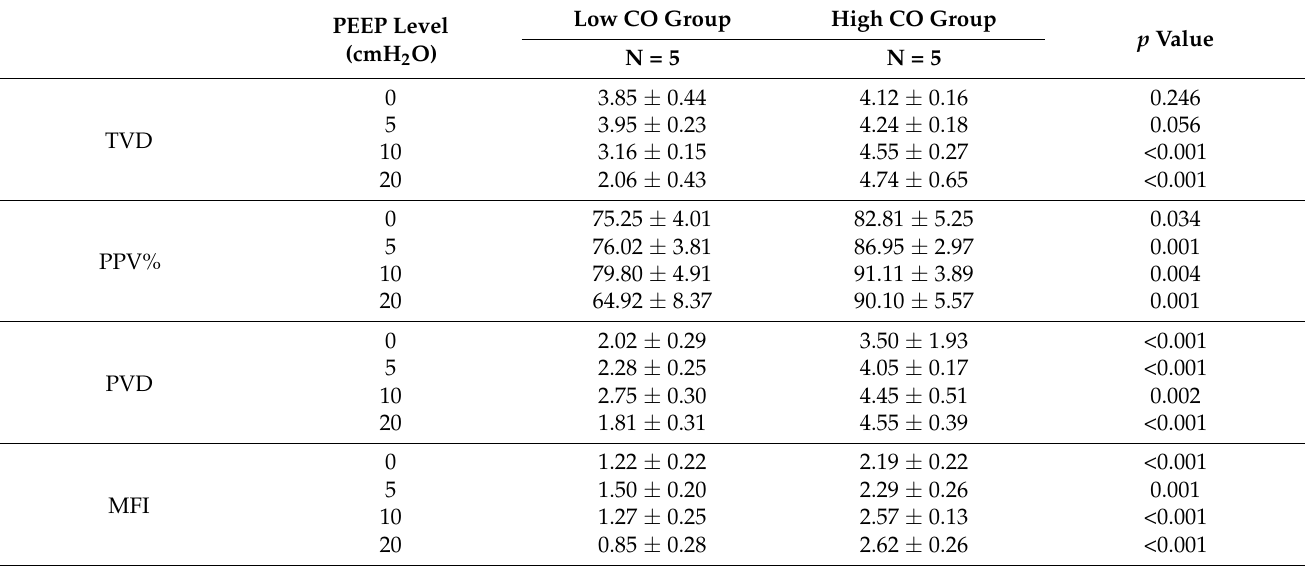
Table 3. Physiological regulation mechanism of pulmonary microcirculation under mechanical ventilation at different cardiac outputs and PEEPs.